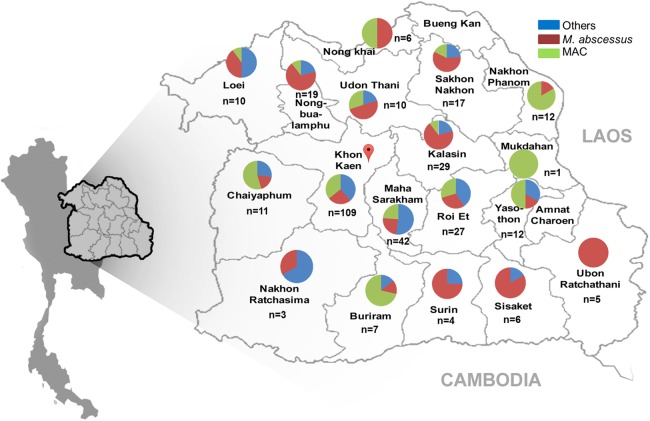
Geographical distribution of NTMs causing NTM infection Northeast Thailand.The distribution of NTM species (n = 330) isolated from 145 cases in Northeast Thailand is shown. Five NTM isolates came from patients outside Northeast Thailand. Map pin indicates the location of Srinagarind Hospital.